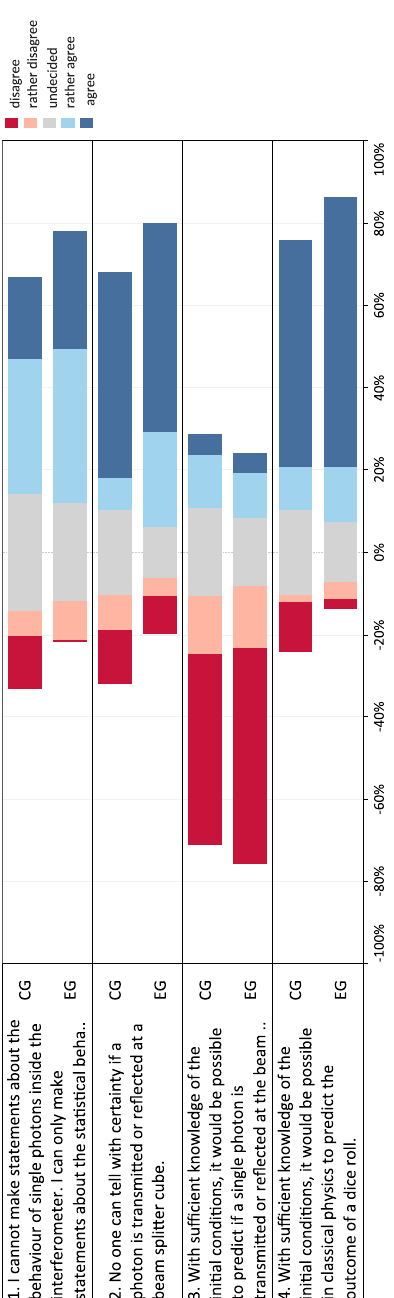
FIG. 12. Diverging stacked bar chart visualizing the distribu- tion of student ratings on all items of the scale on the quantum objects ’ properties and behavior (cf. Table II).